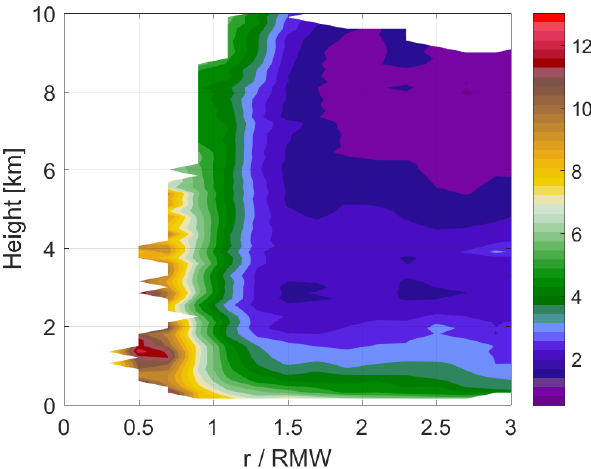
Figure 1. Composite TKE derived from airborne radar data from 116 radial legs of P3 flights in the 2003–2010 hurricane seasons as a function of height and the radius normalized by the radius of maximum wind